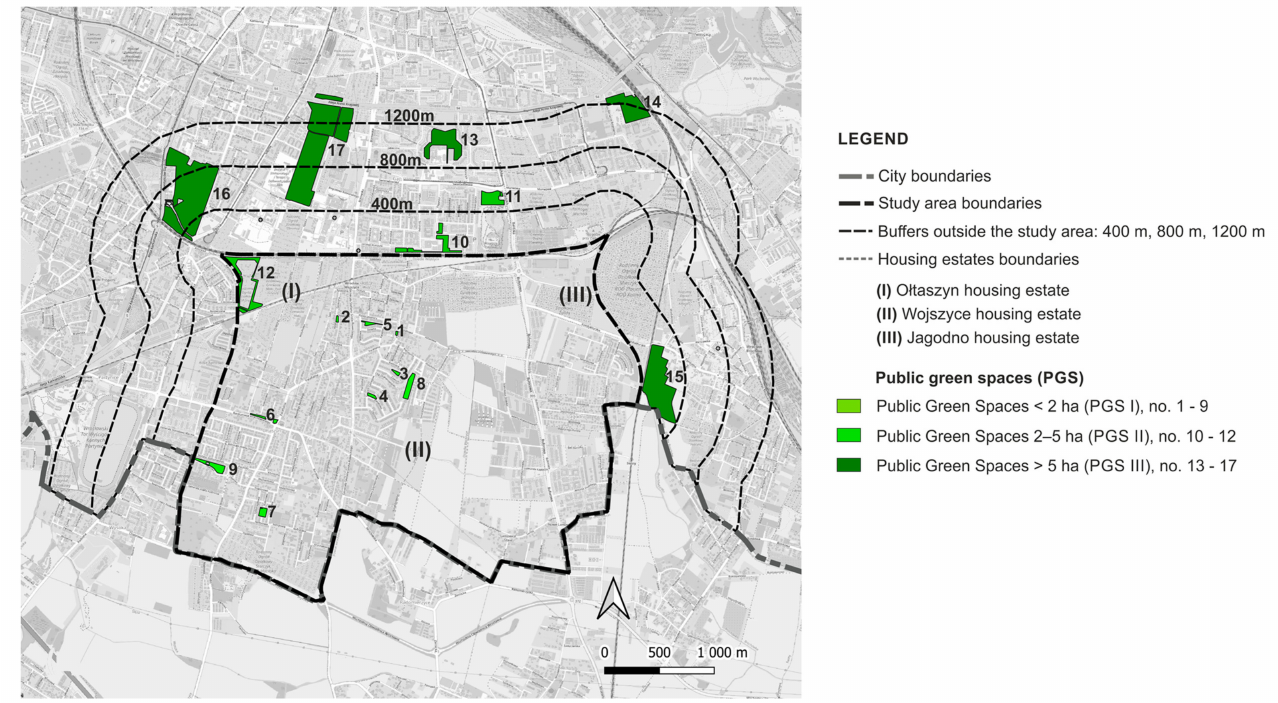
Figure 4. PGS identified in the study area and in buffer zones (400 m, 800 m, 1200